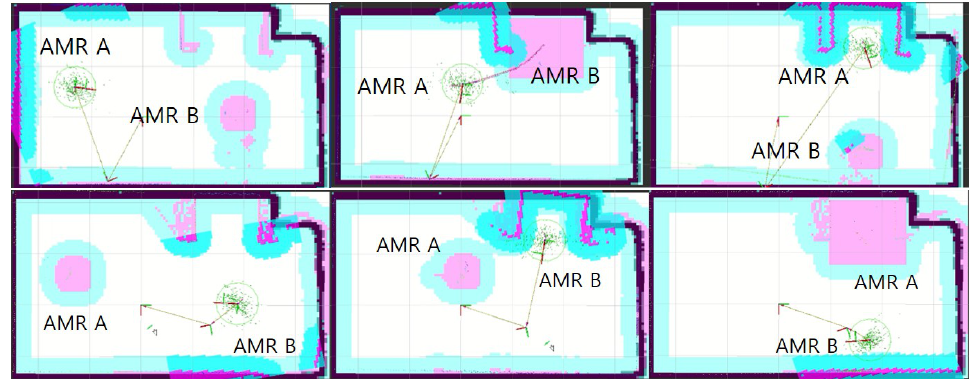
Figure 13. The cost maps of AMR A and B in the exclusive working region under the region